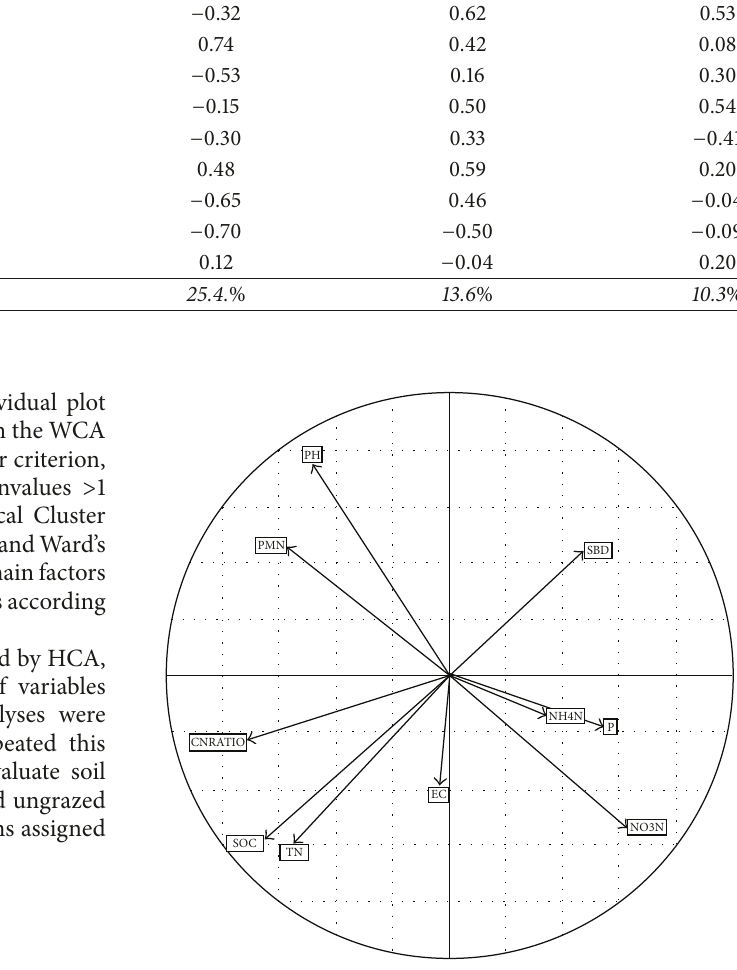
Figure 1: Spatial representation of measured variables on the first factorial map of the principal component analysis (PCA): SBD, soil bulk density; EC, electrical conductivity; PH, soil pH; NO3N, soil nitrate; NH4N, soil ammonium; P, available P; PMN, potentially mineralizable N; SOC, soil organic carbon; TN, total nitrogen; CNRATIO, soil carbon to nitrogen